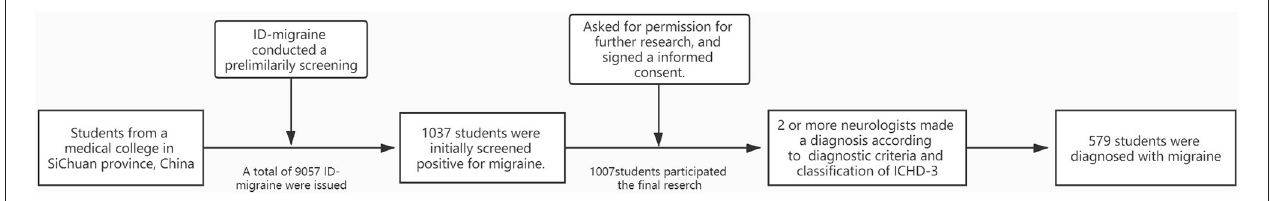
FIGURE 1 | The screening process of medical students with